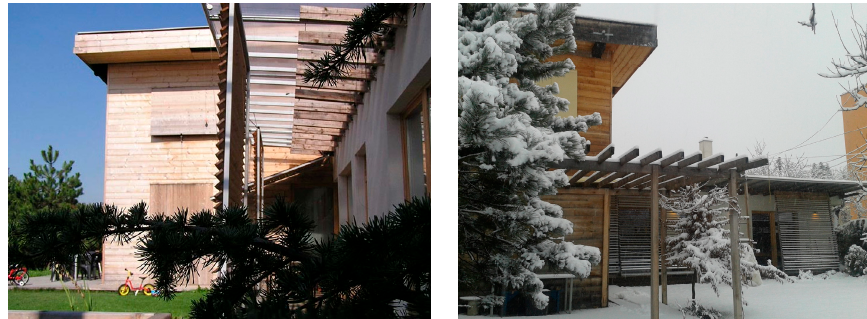
Figure 1. Family house in